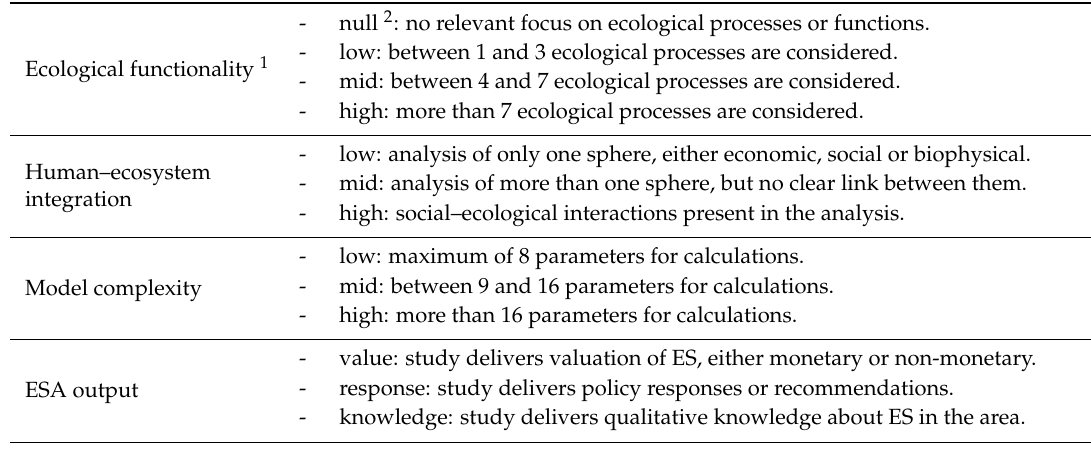
Ecological functionality